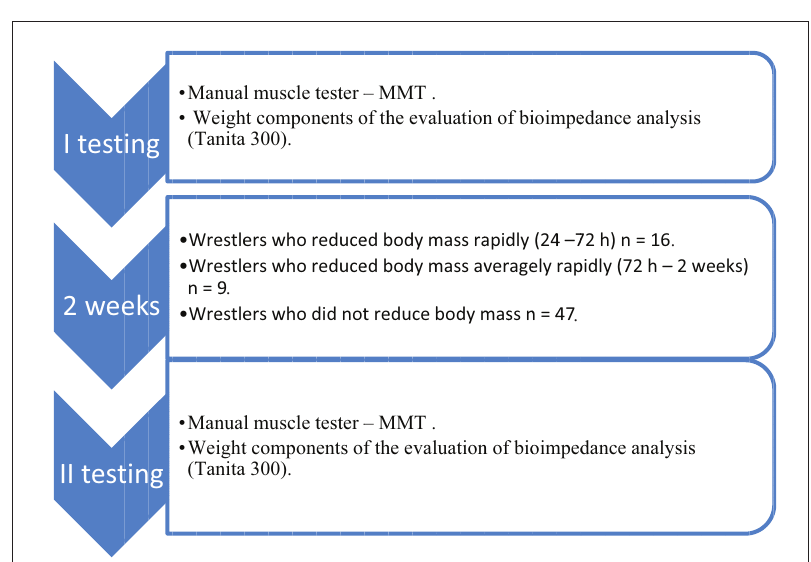
Figure 1. The course of